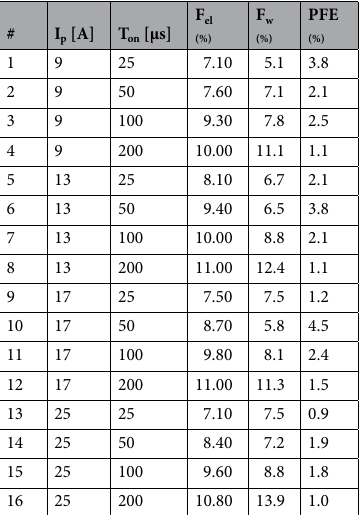
Table 4. Absorption coefficients of the electrode (F el ), and the workpiece (F w ), and PFE.